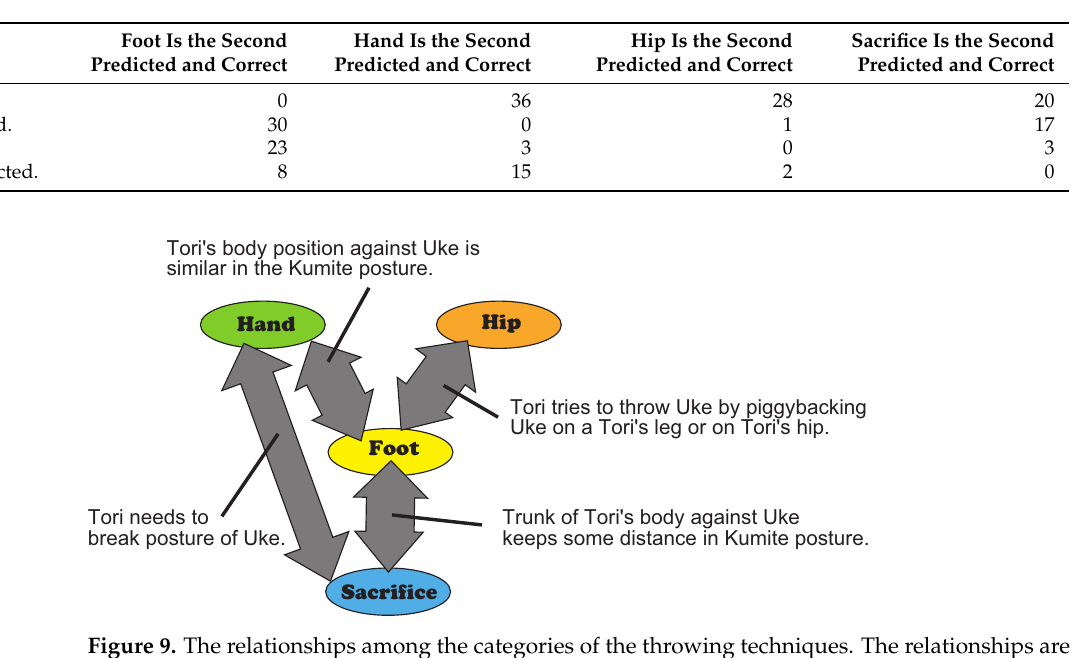
Table 5. The number of predicted results in the first and the second topmost predicted results when the actual throwing technique is resulted in the second rank. For example, when the foot category is predicted in the second rank and the result matches to the actual throwing technique, the number of predicted cases as the hand category in the topmost predicted category is 30.